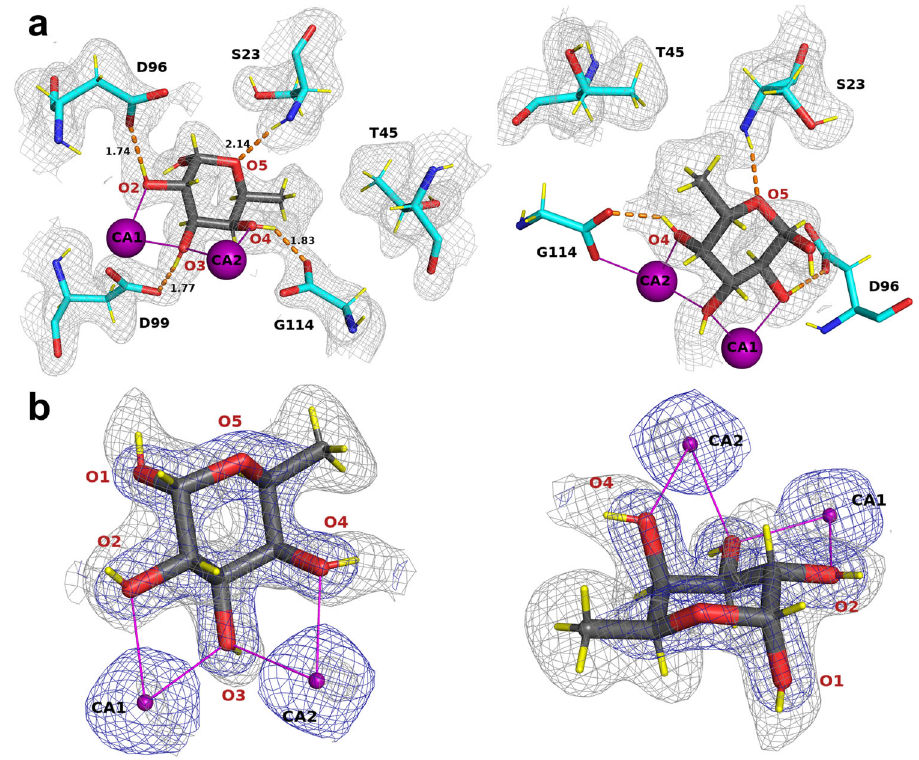
Fig. 2 Fucose-binding site in the neutron structure of the D-LecB/Fuc-d 12 complex. a Two different orientations of the same fucose-binding site (chain B). Fucose is represented as dark gray sticks and protein as cyan sticks. The calcium ions are shown as purple spheres and deuterium atoms are shown as yellow sticks. The hydrogen bonds and metal coordination are shown as orange dashed lines and as solid purple lines, respectively. The distances are given in Å. The 2m F o -D F c neutron map (gray mesh) is contoured at 0.8 σ . Amino acids involved in coordination of the calcium ions were omitted for clarity (Asn21, Asn103, Asp101, Asp104, Glu95). The fi rst view (left) highlights the hydrogen-bonding network between fucose and the protein. The second view (right) shows the hydrophobic contact between methyl group of fucose and methyl and -CH 2 groups of the Thr45 and Ser23 side chains, respectively.